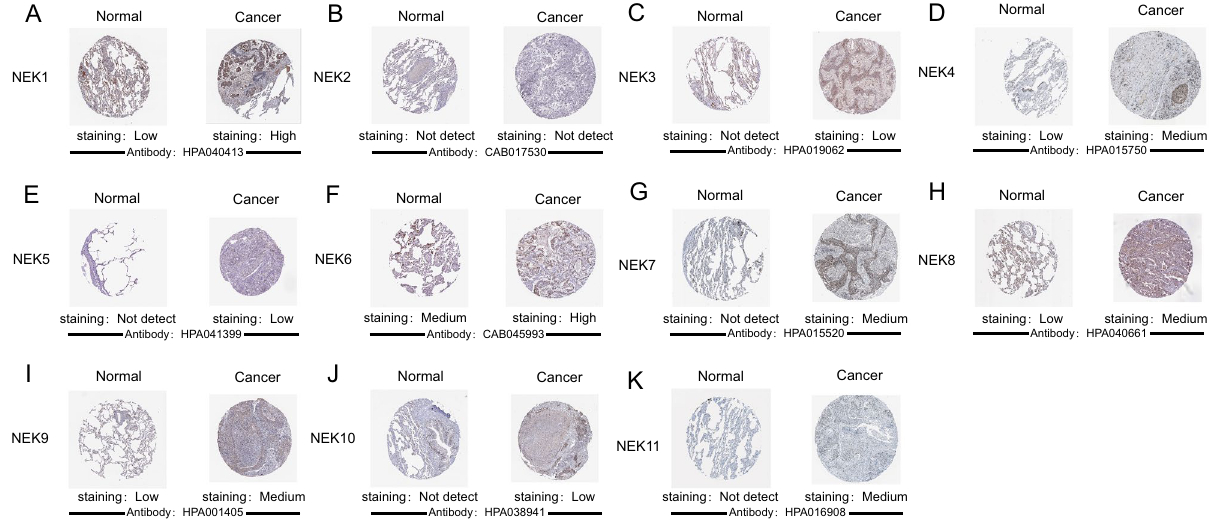
Figure 3. Representative immunohistochemistry images of distinct NEKs family members in NSCLC and normal lung tissues. From A to K represent the representative immunohistochemistry images of NEK1 to NEK11 in NSCLC and normal lung